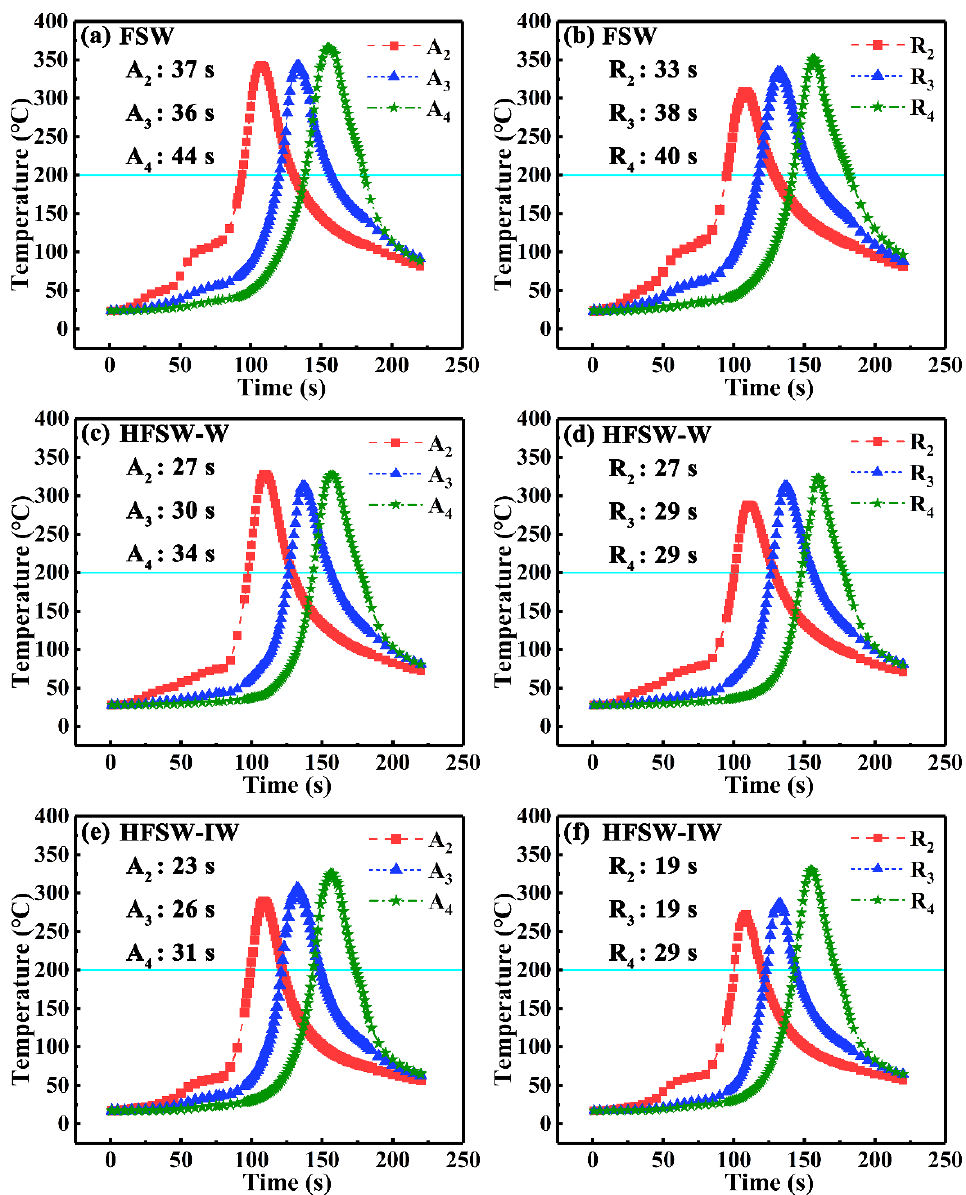
Figure 6. The durations of high temperature calculated from the thermal curve of: ( a ) feature points A 2 to A 4 at the advancing side under the FSW condition; ( b ) feature points R 2 to R 4 at the retreating side under the FSW condition; ( c ) feature points A 2 to A 4 at the advancing side under the HFSW-W condition; ( d ) feature points R 2 to R 4 at the retreating side under the HFSW-W condition; ( e ) feature points A 2 to A 4 at the advancing side under the HFSW-IW condition; ( f ) feature points R 2 to R 4 at the retreating side under the HFSW-IW condition.